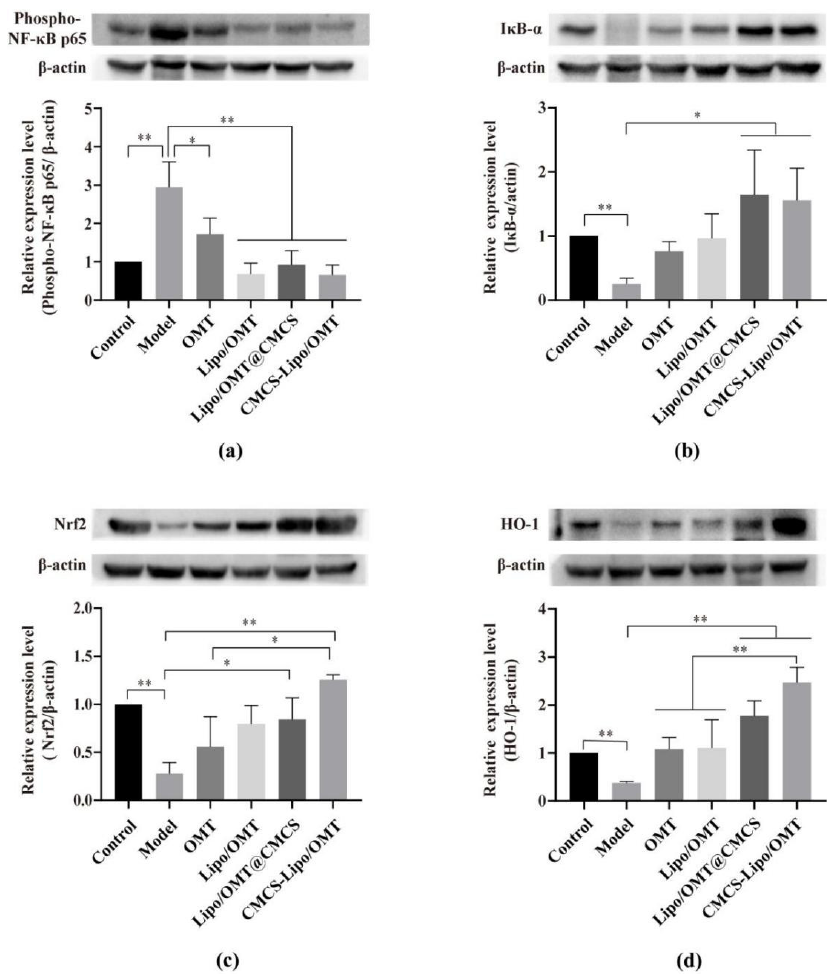
Figure 6. The protein expression of ( a ) phosphor-NF- κ B p65, ( b ) I κ B- α , ( c ) Nrf2 and ( d ) HO-1 in the lung tissues of emphysema mice after treatment by OMT preparations. All data are expressed as mean ± SD ( n = 3). * p < 0.05, ** p < 0.01.